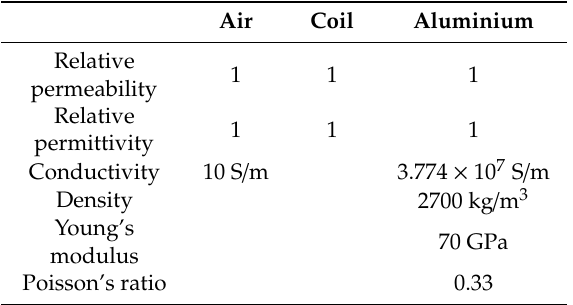
Table 1. Parameters of samples employed in the 2-D FE model.